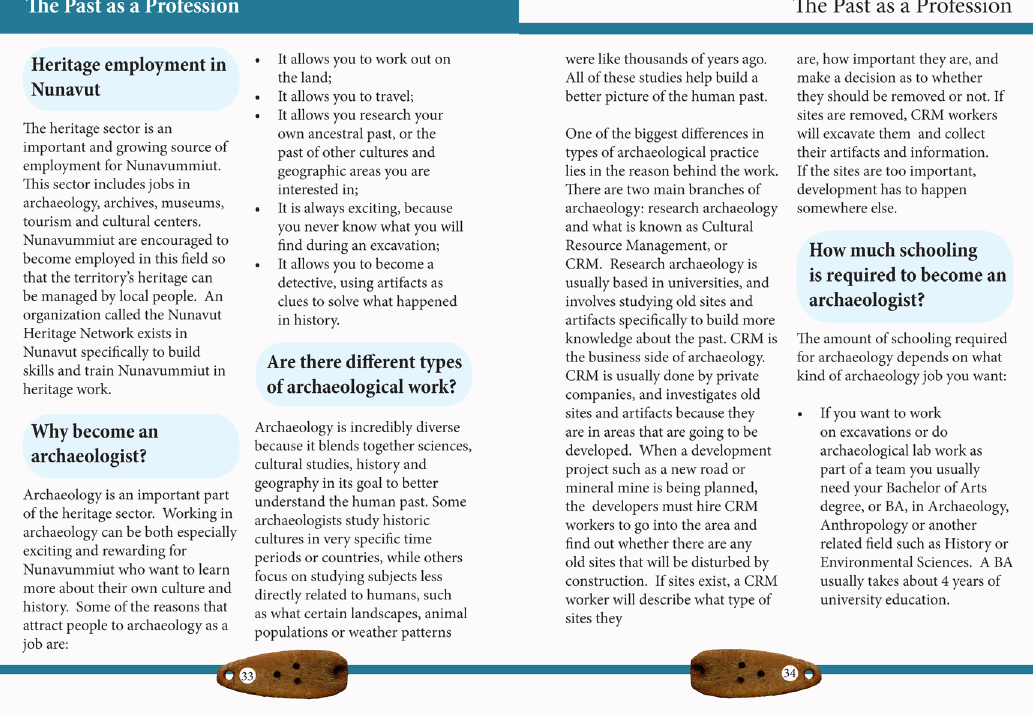
Figure 4: Students are introduced to the idea of archaeology as a potential profession in the Guide to Nunavut Archaeology and Artifacts for Northern Students